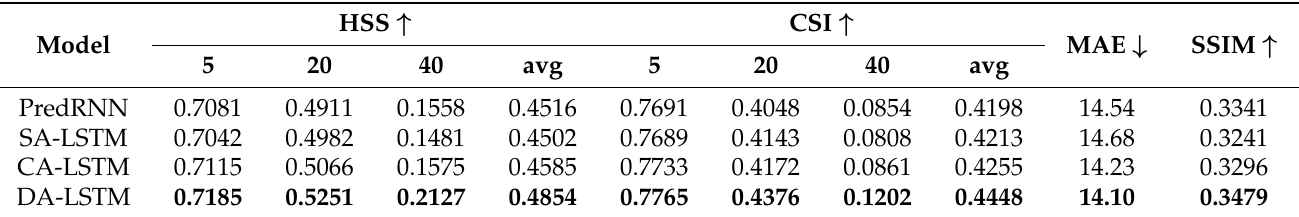
Table 4. Comparison results of attention mechanism ablation study on the CIKM AnalytiCup 2017 competition dataset in terms of HSS and CSI. Bold denotes the best evaluate index among all